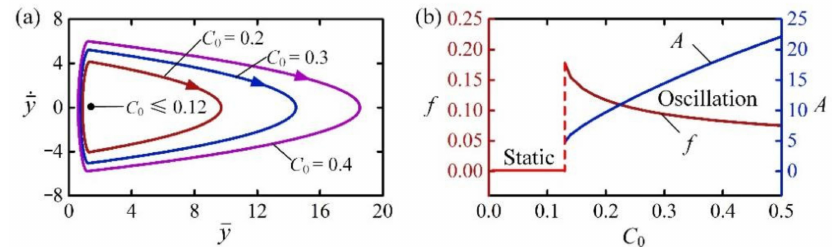
Figure 7. The effect of contraction coefficient on the self-jumping, for I 0 = 2, H = 4, β = 0.01, g = 1, . = 0.001, E = 500, y = 30, and = 0. ( a ) Limit cycles. ( b ) Frequency and amplitude. n g = 0.4, p y am 0 0 With the increase of C 0 , the frequency of self-jumping decreases while the amplitude